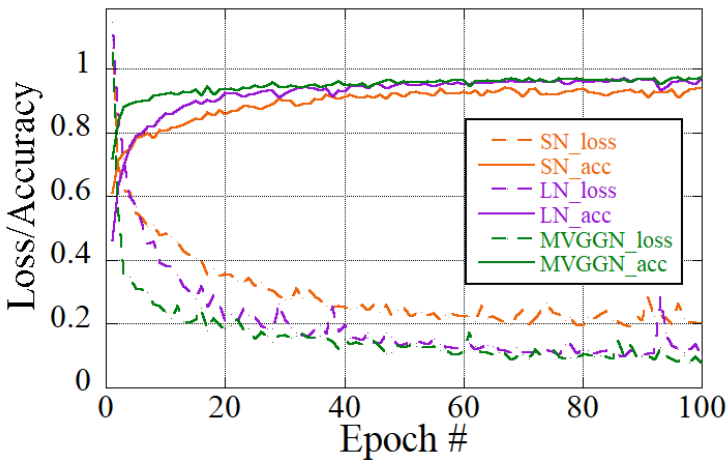
Figure 12. Training loss and accuracy of ShallowNet (SN), LeNet (LN), and MiniVGGNet (MVGGN) models.